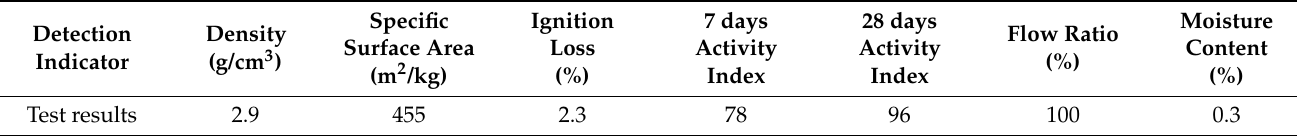
Table A5. Physical and chemical properties of mineral powder.